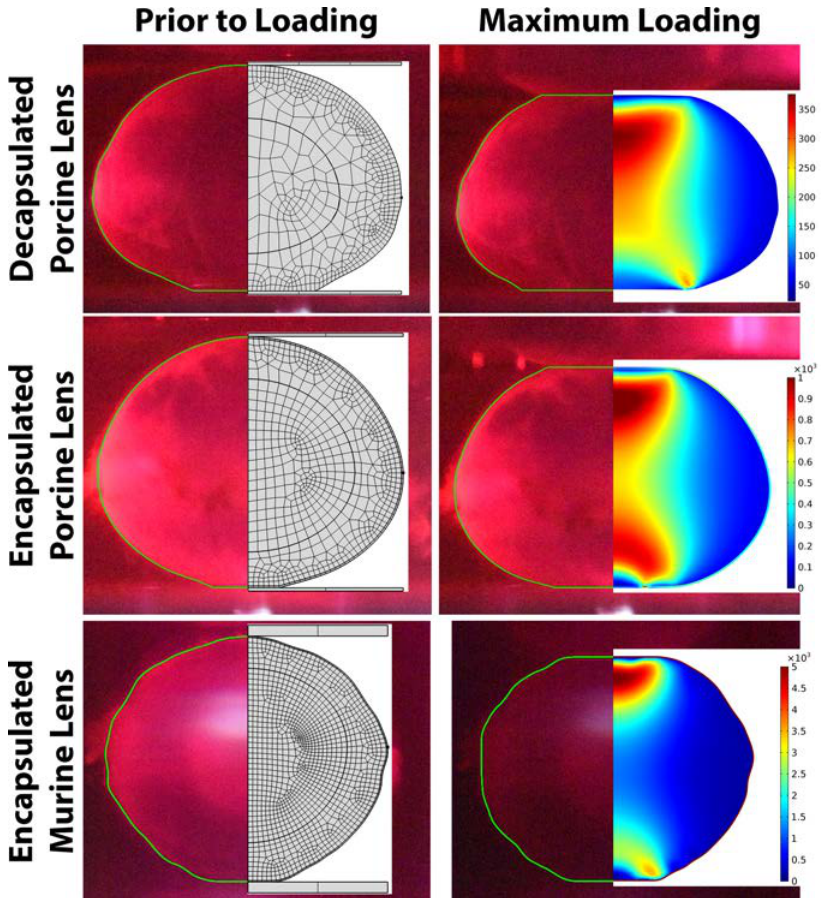
Fig. 2. Digital image analysis was used to identify edge pixels (green) in high-resolution photographs of the lenses before (left) and during (right) compression. Inset left: A quadrilateral mesh was generated automatically for each lens based on its unloaded geometry. Inset right: von Mises stresses (shown in Pa) generated in the lens during maximum compression for the optimized model.